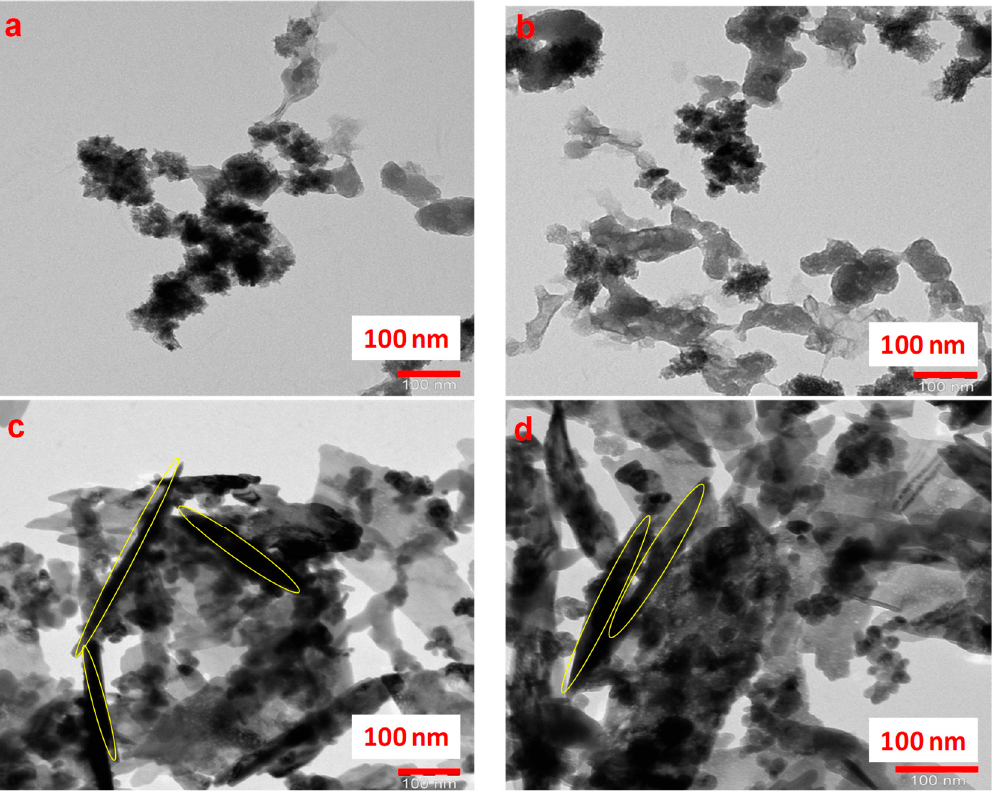
Figure 2. ( a ), ( b ) Transmission electron microscopy (TEM) images of ZnO nanoparticles (A1) Figure 2. ( a , b ) Transmission electron microscopy (TEM) images of ZnO nanoparticles (A1) prepared.by procedure (a); ( c , d ) TEM images of ZnO nanoparticles (B1) prepared by procedure (b) using S.